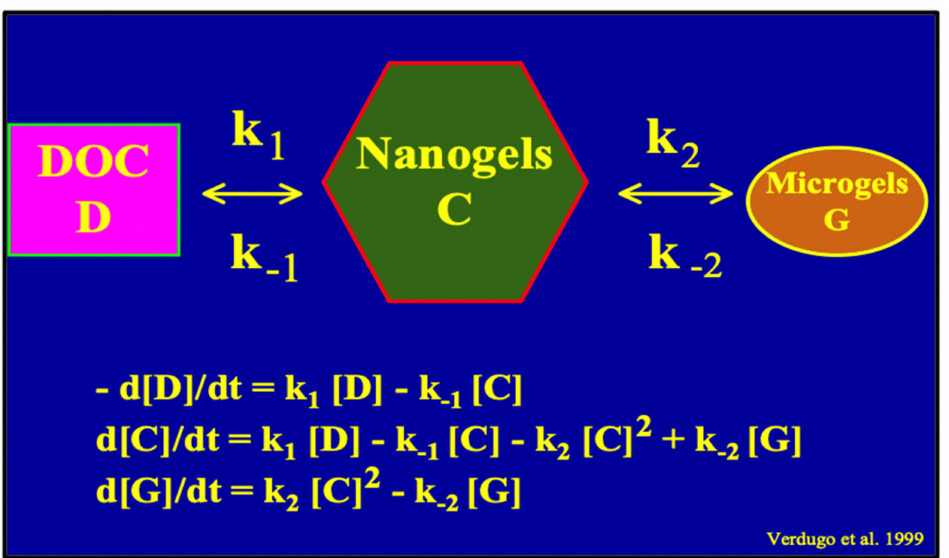
Figure 16. A simple second-order kinetics mathematical model of MBP assembly can be formulated by assigning two correspondent equilibrium constants k 1 and k 2 to the assembly reaction. Square parenthesis refers to Carbon concentration in each of the subsequent steps from DOC to Nano and MGs. From the MG step, organic carbon becomes available to microorganisms, and flux becomes irreversible as carbon enters the food web escalator (Figure 1). Notice that MGOC can be a sensitive indicator of the balance between supply and demand of carbon in marine carbon